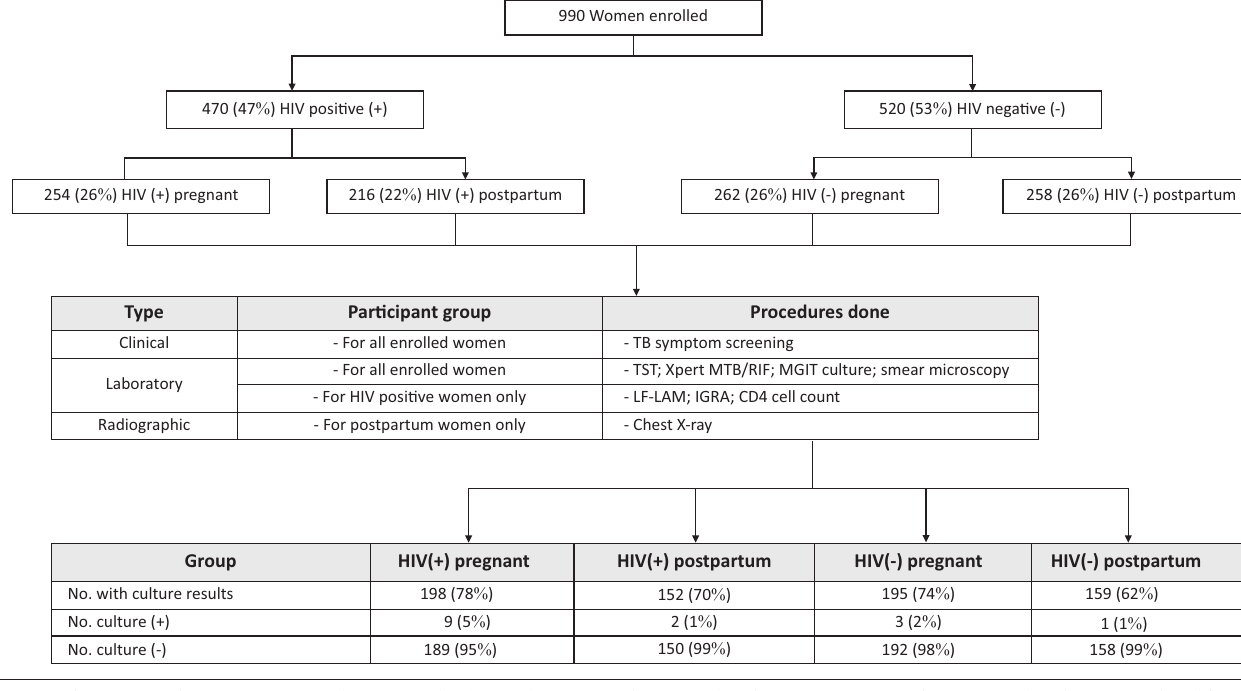
FIGURE 2: Enrolment categories and culture results of pregnant and postpartum women attending antenatal and postnatal care clinics in Eswatini between April and November 2015.